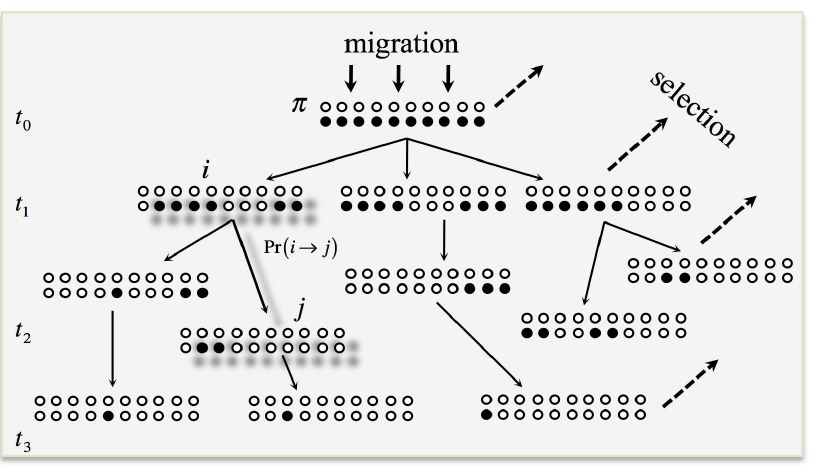
Figure 1. A subset of the lineage descending from an immigrant haplotype p carrying 10 genes. After selection, the genotypes carrying foreign genes (solid black dots) recombine with the resident genotypes (shown as the rows of open dots), so that the average number of foreign alleles per genotype is reduced every generation t 0 { 3